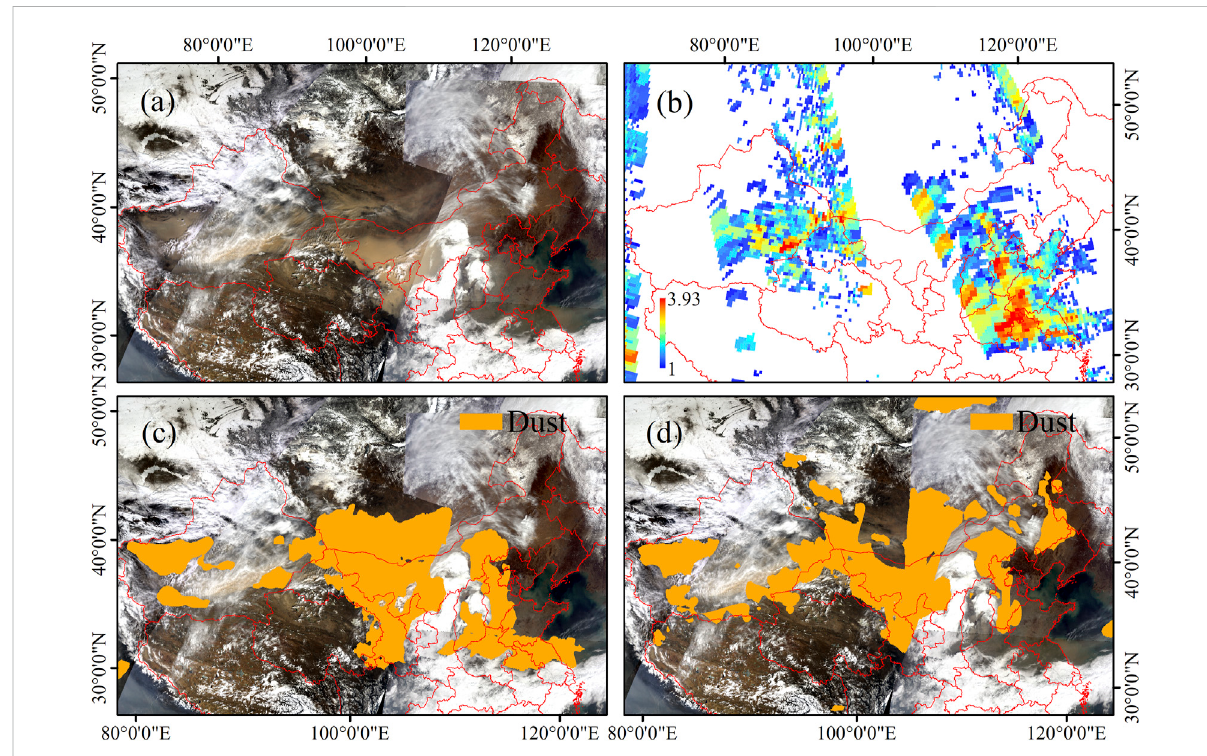
FIGURE 6 Spatial distributions of MODIS RGB image (bands: 1-4-3) (A) , OMI AI product (B) , detection results of space sandstorms in MODIS images with LSR (C) , and detection results of space sandstorms in MODIS images without LSR (D) on 16 March